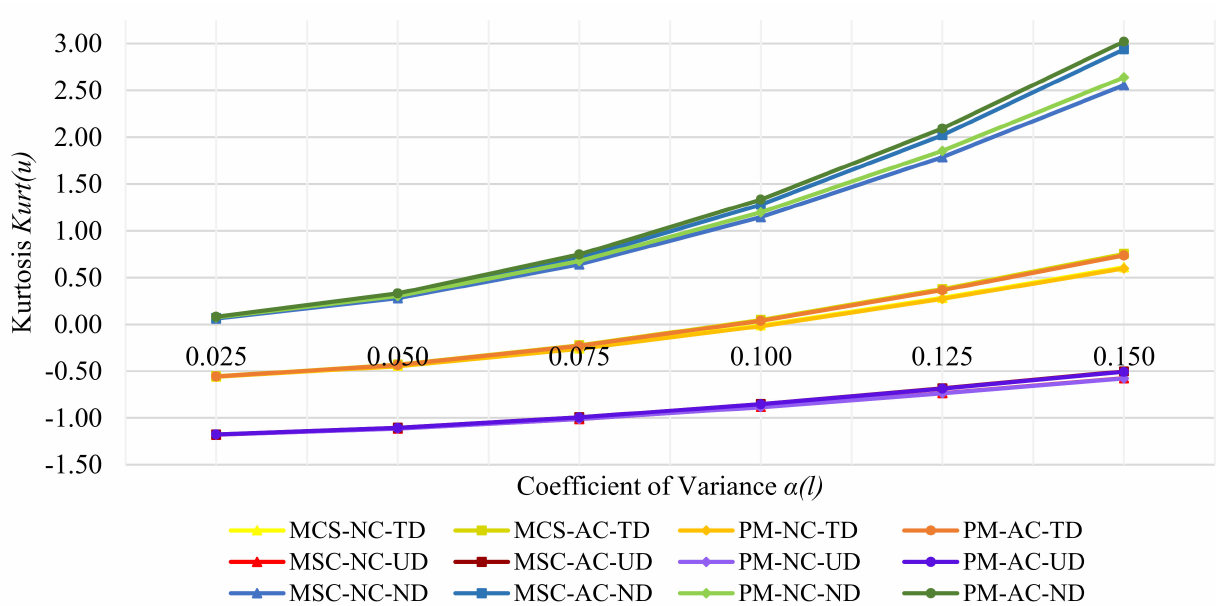
Figure 9. Kurtosis Kurt ( u ) in the